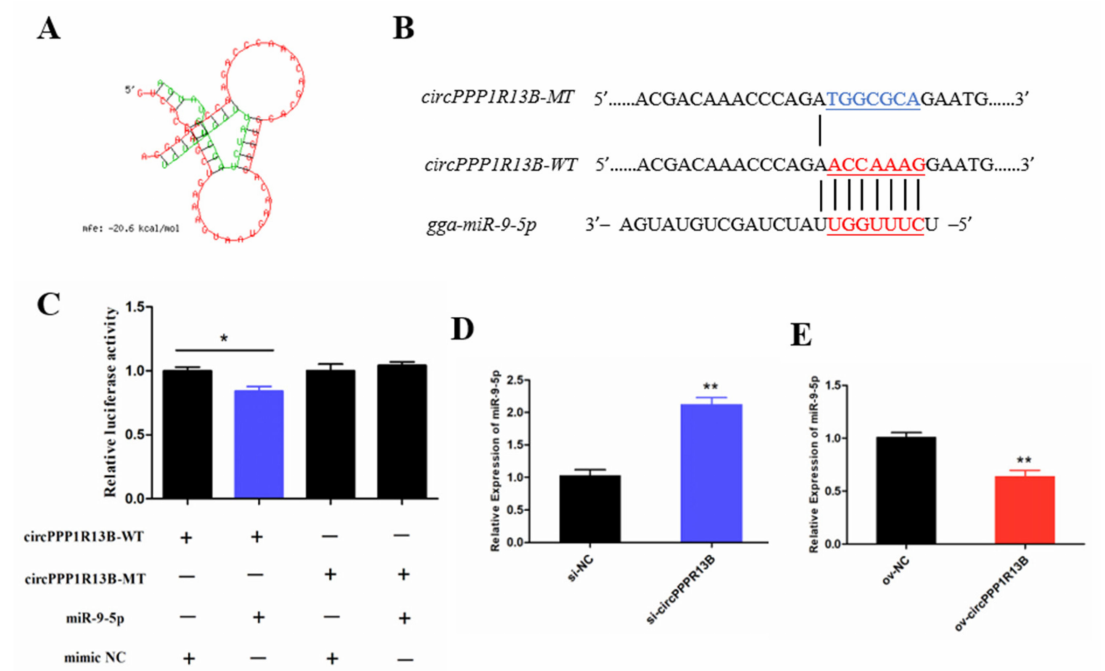
Figure 2. CircPPP1R13B directly targets miR-9-5p. ( A ) the target site of miR-9-5p on circPPP1R13B predicted by RNAhybrid software. ( B ) wild type and mutant type of miR-9-5p targeting site used for dual luciferase reporter vector construction. ( C ) Relative luciferase activity of wild type or mutant type reporter vectors co-transfected with miR-9-5p mimic or negative mimic. ( D ) The expression of miR-9-5p after circPPP1R13B knockdown in chicken SMSCs. ( E ) The expression of miR-9-5p after circPPP1R13B overexpression in chicken SMSCs. Asterisk indicate significant differences from the respective control (* , ** p <